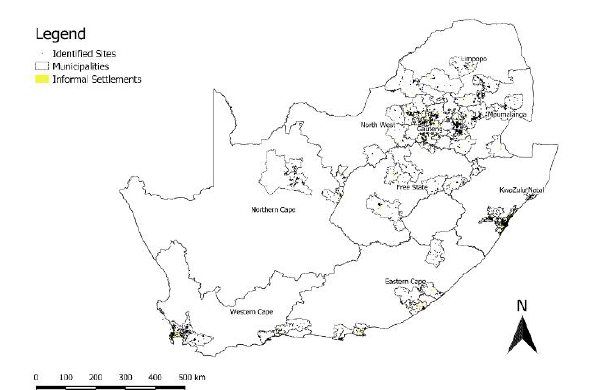
Figure 6: Heritage resources within 1km of informal